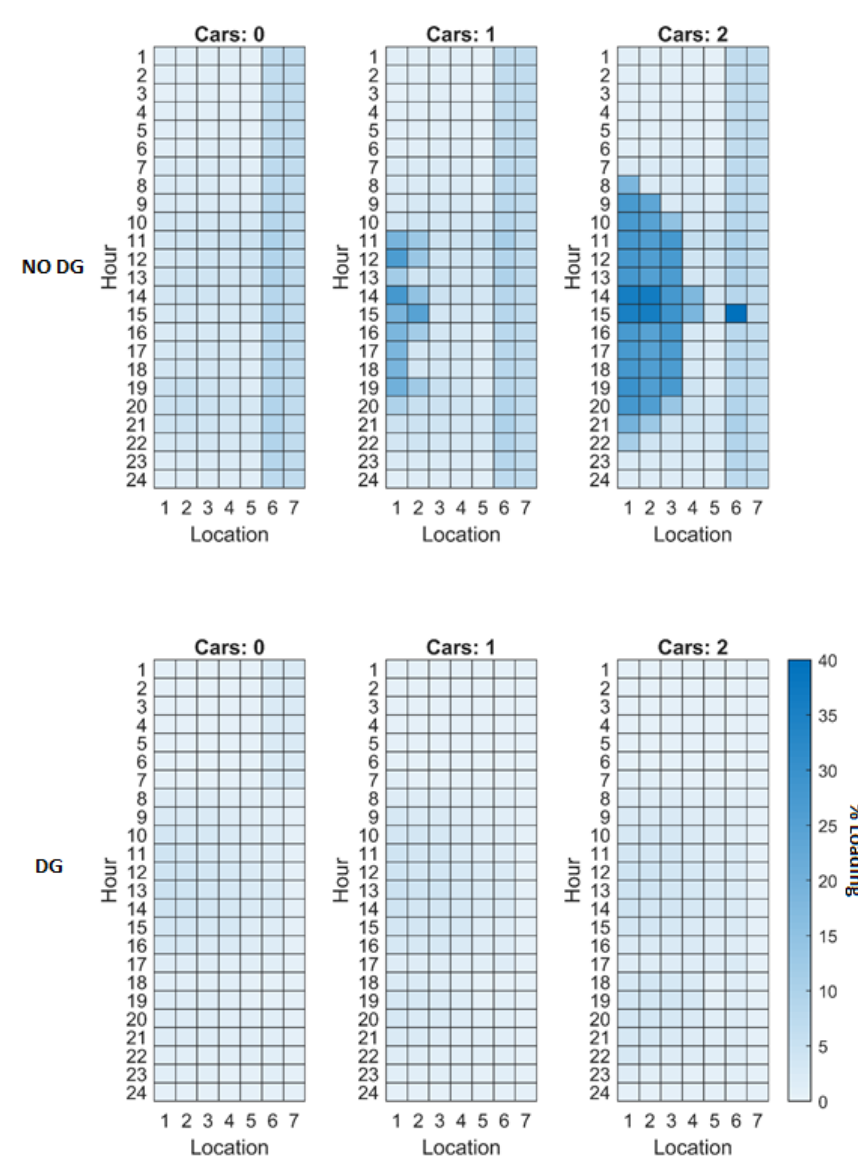
Figure A9. Maximum observed line loading (percentage) across the entire network (network 4) with and without distributed generation (DG).